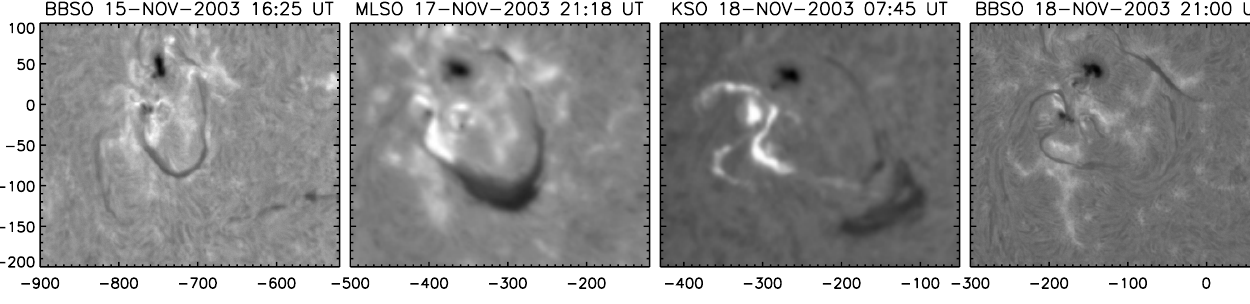
Fig. 3. Evolution of the filament from 15 November until 18 November using H α observations from BBSO, MLSO, KSO, BBSO (left to right). When the active region is close to the limb (left panel, BBSO) the two separate filaments are visible, with the northern filament located at ( −